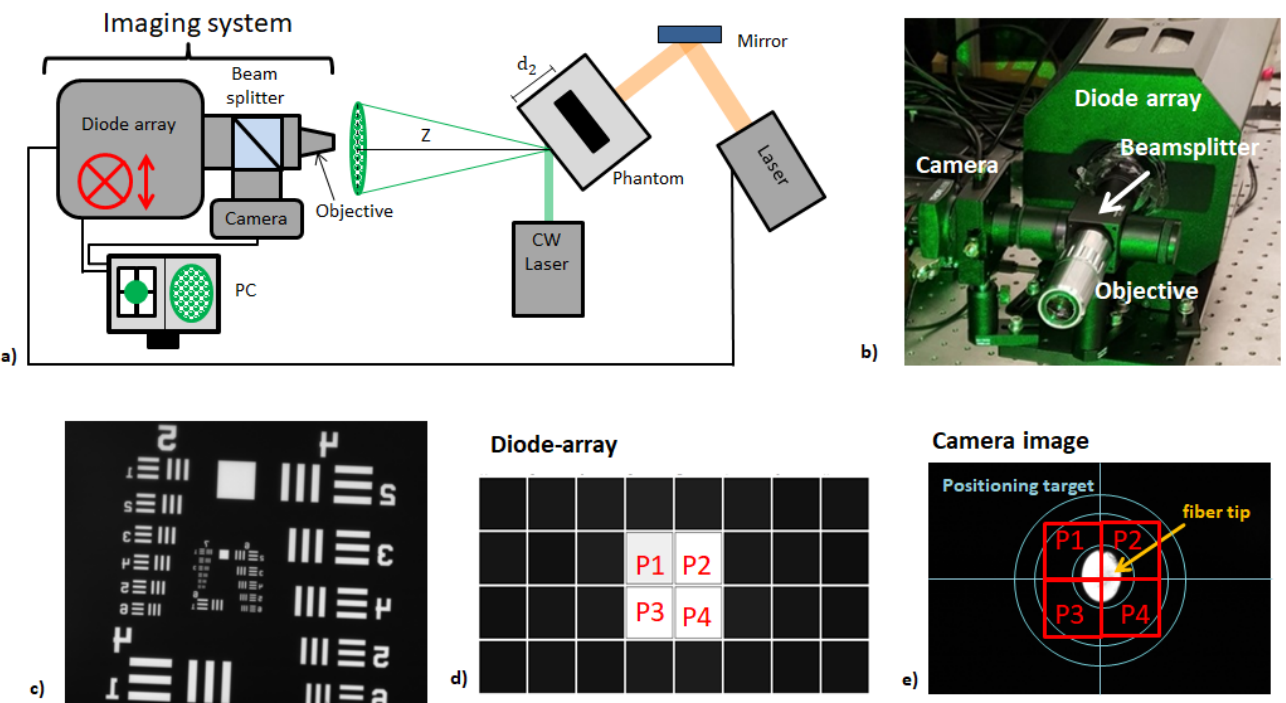
Figure 2. ( a ) Experimental setup (transmission mode) for the remote photoacoustic measurements using the diode array sensing system. The imaging system can be moved mechanically in lateral directions, which is indicated by the red marks. ( b ) Picture of the sensing system. ( c ) The magnification of the sensing system is calculated at 5 using a USAF 1951 Test Target. ( d , e ) The camera position of the sensing system is calibrated using a multi-mode fiber. The diode signals and the camera image are shown when an illuminated fiber is placed in their center. Figures after